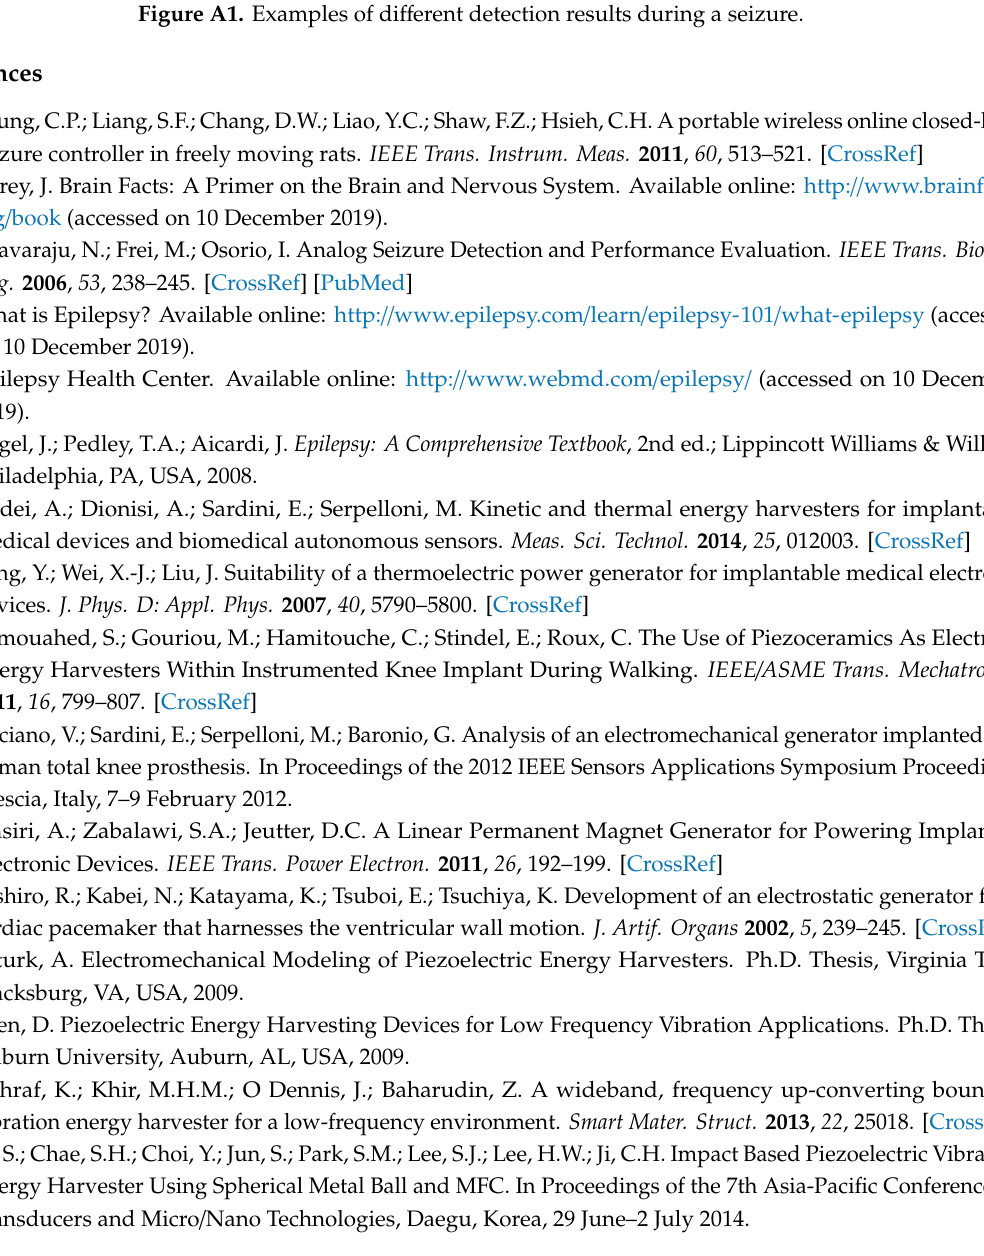
Figure A1. Examples of different detection results during a seizure.